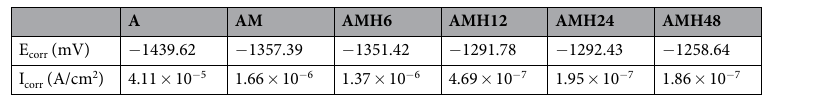
Table 2. Electrochemical corrosion measurements from potentiodynamic polarization conducted in HBSS of the A-, AM-, AMH6-, AMH12-, AMH24- and AMH48-treated